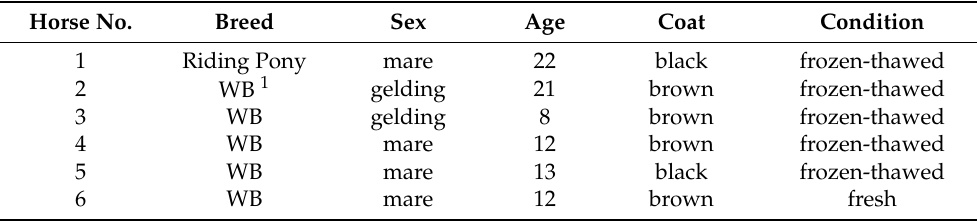
Table 1. Animal data and condition of heads used for orthodontic measurements. Horse No.